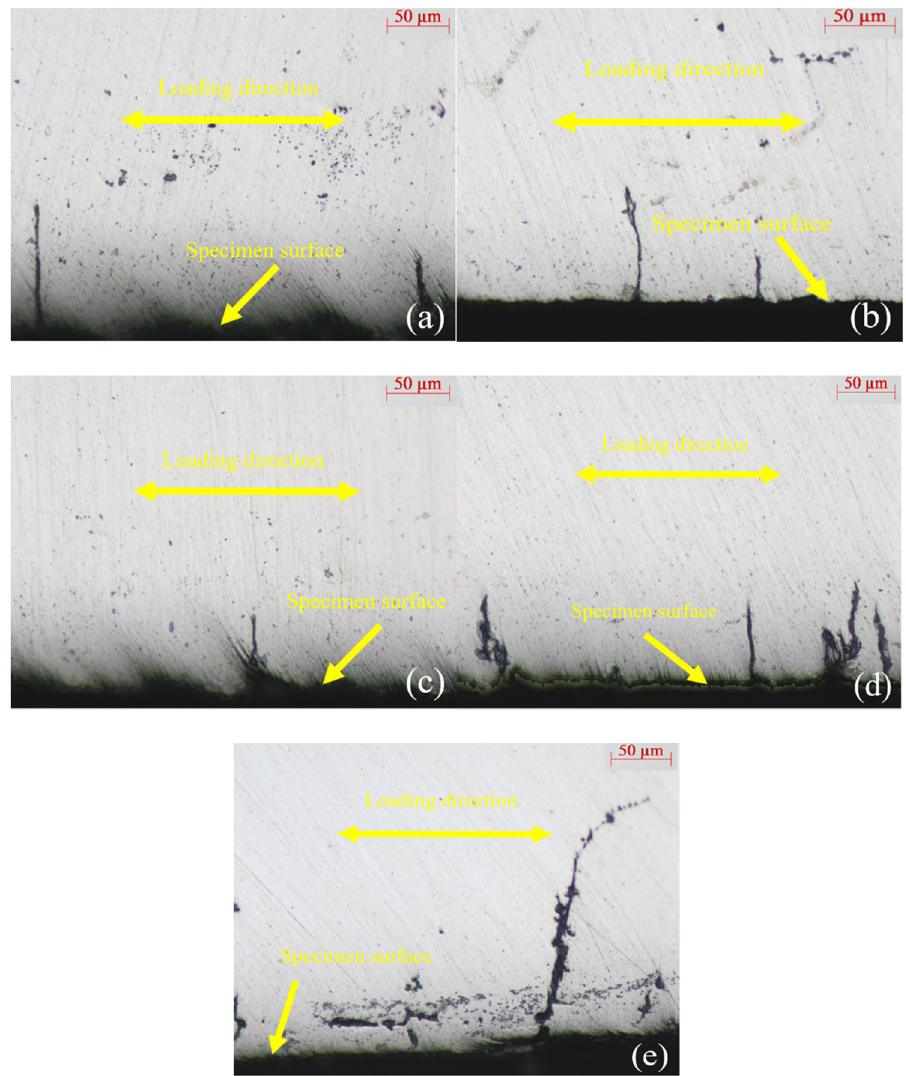
Figure 11: Optical photographs of surface cracks in cross - sectional view under ( a ) IPTMF0.4, 0 s, ( b ) IPTMF0.4, 20 s, ( c ) IPTMF0.4, 40 s, ( d ) IPTMF0.6, 40 s, and ( e ) IPTMF0.8, 40 s conditions.